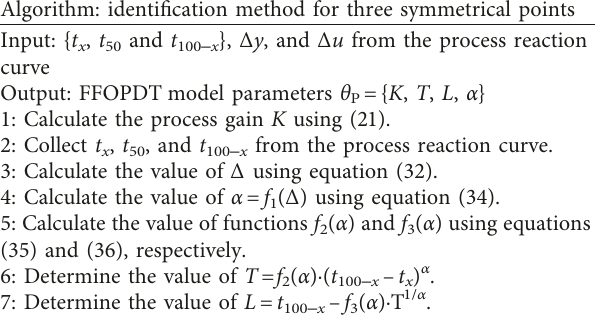
Table 10: Algorithm for determining FFOPDT model parameters θ P � { K , T , L , α } when three symmetrical points { t x , t 50 , t 100 ‒ x } on the reaction curve are specified. Algorithm: identification method for three symmetrical points